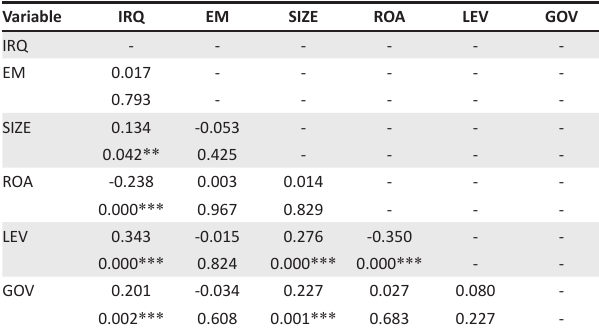
TABLE 5: Univariate results – Spearman correlations.